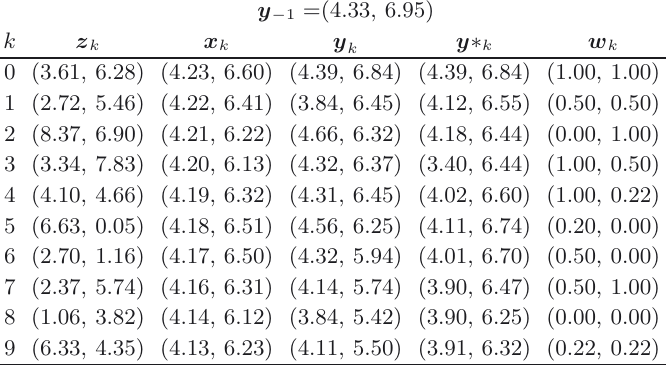
Table 3. Measured ( z ), theoretical ( x ), and weight ( w ) vectors of Figure 5; Estimated vectors ( y ) of Figures 5a and 5b; Estimated vectors ( y ∗ ) of Figures 5c and